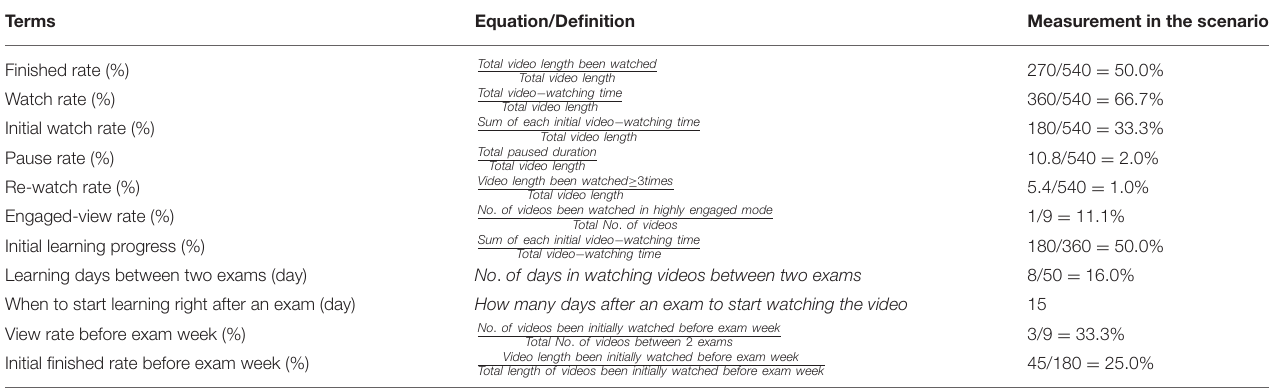
TABLE 1 | Learning analytics metrics glossary and definition.